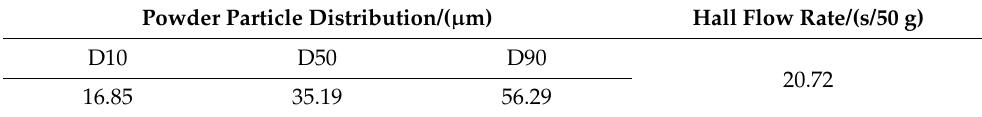
Table 2. Powder particle distribution of K438.